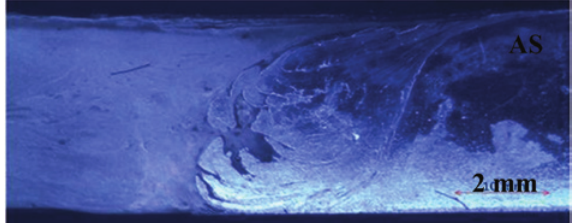
Figure 4: Photomicrograph of cross sectioned sample at 305 rpm and 50 mm/min welding speed, obtained from weld coupon of Figure 3.